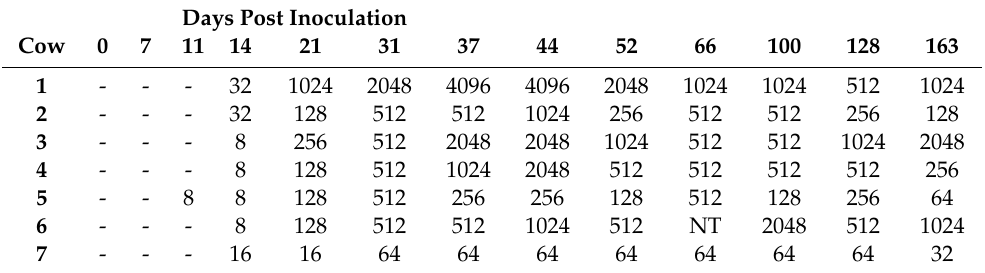
A dash indicates that neutralising anti-Bungowannah virus antibodies were not